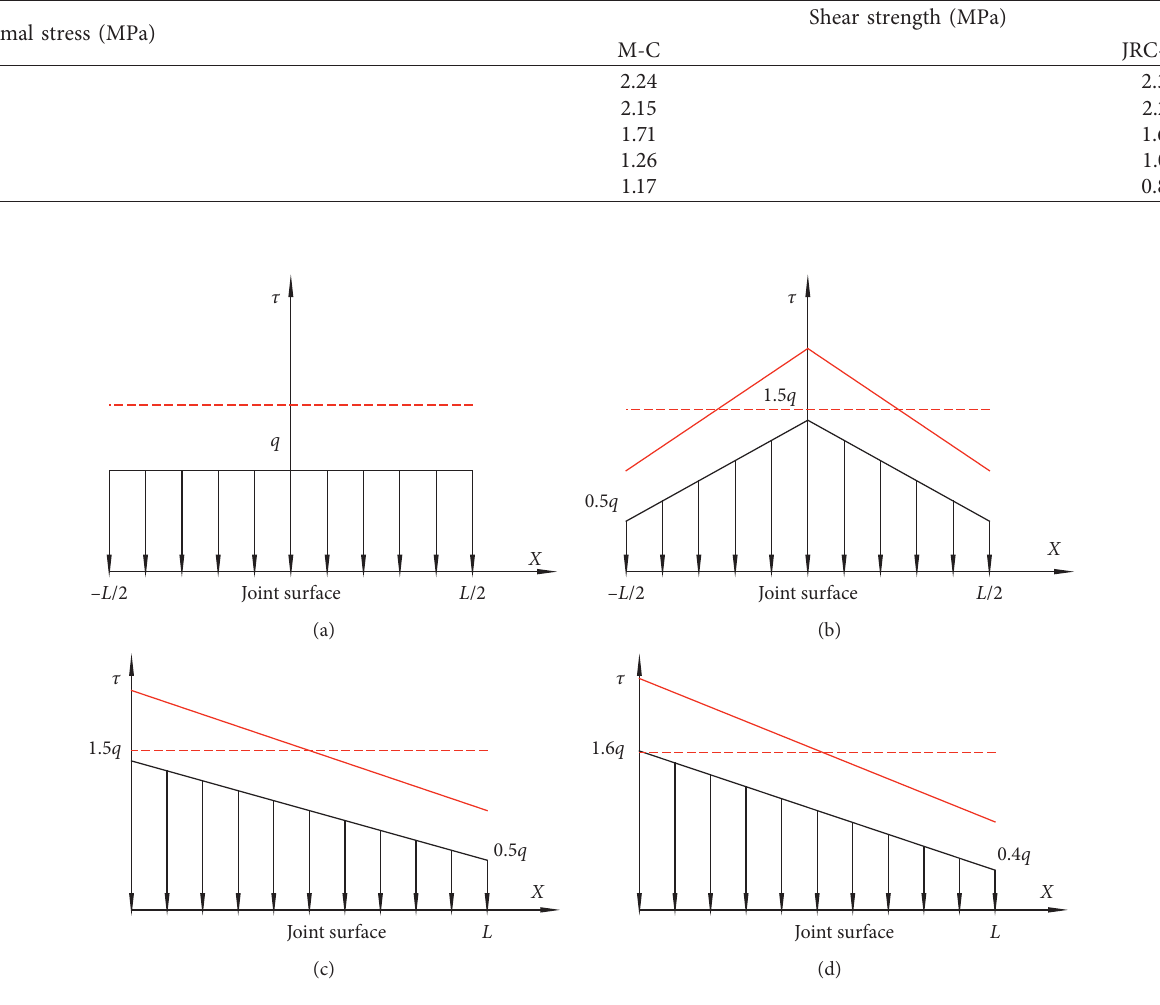
Figure 5: Peak shear strength and the average shear strength of the joint in JRC-JCS model (peak shear strength: the solid red line; average shear strength: the dashed red line). (a) Uniform distribution. (b) Symmetric distribution. (c) Linear distribution. (d) Linear